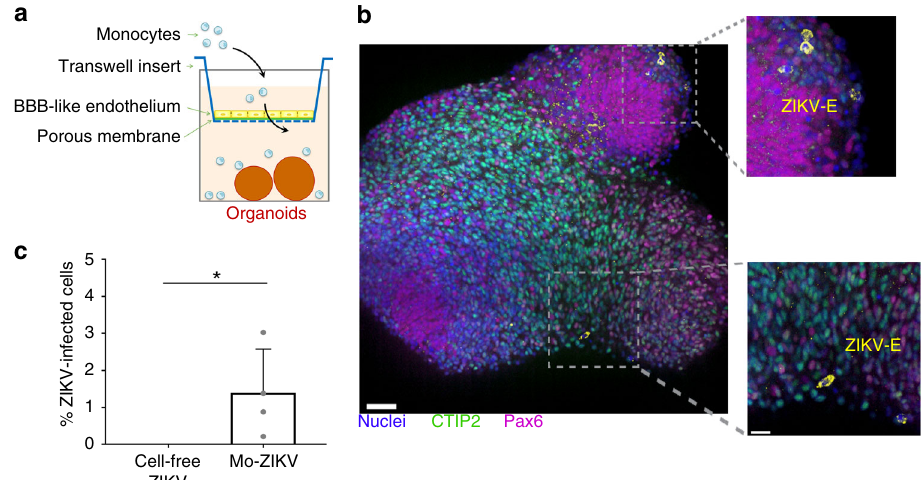
Fig. 9 Transmigrated ZIKV-infected monocytes promote viral dissemination to cerebral organoids. a Representative scheme of the experimental design. Neural organoids were located under a transwell where hCMEC/D3 cells were previously grown for 7 days. On top of a transwell, ZIKV-infected monocytes from two healthy donors, not-infected monocytes, cell-free ZIKV, or mock were added. After an overnight incubation, the transwells were removed and the organoids were cultured for 2 or 9 days, and then they were fi xed and processed for b immuno fl uorescence or c fl ow cytometry. The bar graph shows the mean of an experiment performed in duplicate ± SD. Two-tailed p value < 0.05 (*). Statistical signi fi cance was determined by using a t test. Scale bar: 50 µ m. Source data in c are provided as a Source Data fi